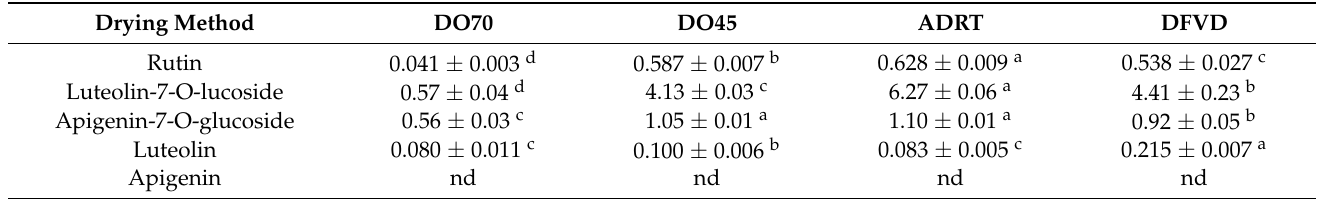
Table 4. Contents of phenolic compounds (mg/g dw) affected by different drying methods. Drying